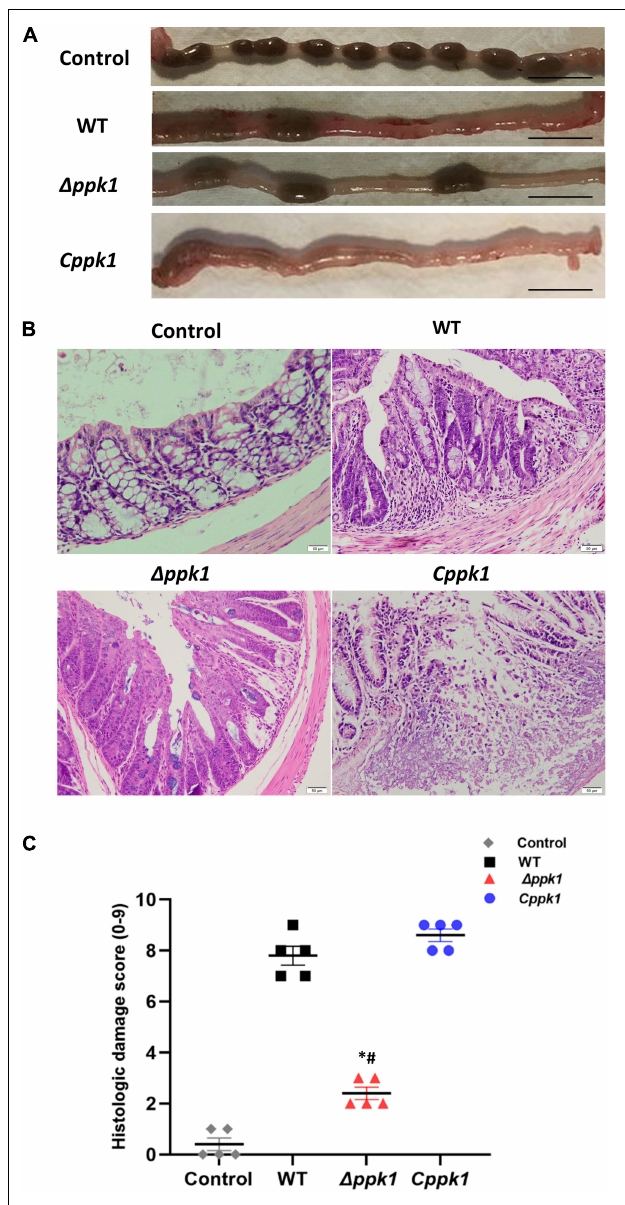
FIGURE 4 | The (cid:49) ppk 1 strain was less pathogenic in BALB/c mice. (A) The colonic morphology of BALB/c mice after the infection. Scale bar: 1 cm. (B) Images of colons after infection. Scale bar: 50 µ m. (C) Histologic damage scores of uninfected (control group), WT, (cid:49) ppk 1, and Cppk 1 strains. *, p < 0.05 as compared with the WT strain; #, p < 0.05 as compared with the Cppk 1 strain.